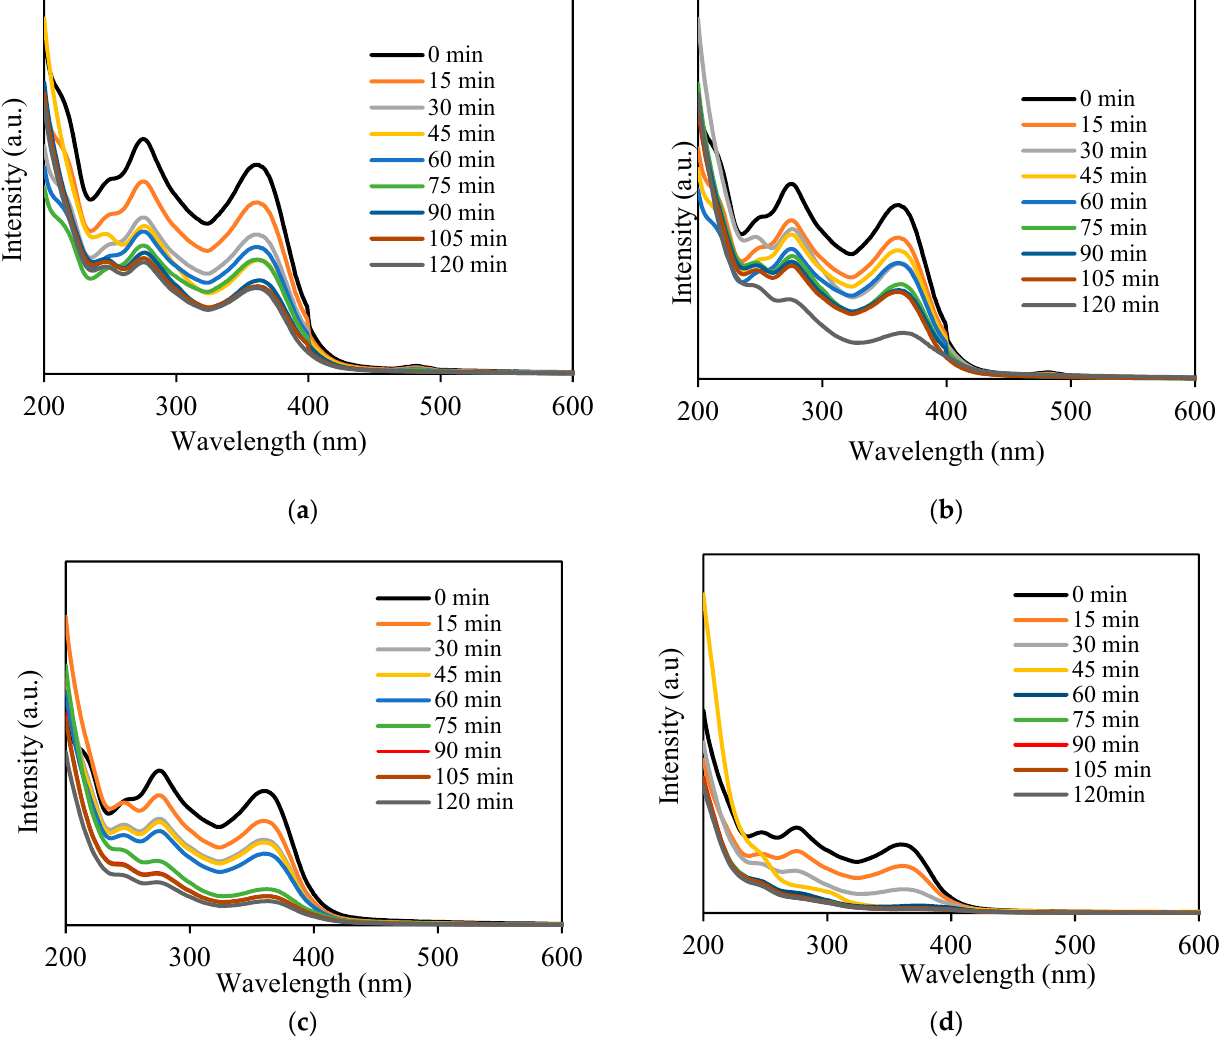
Figure 5. Photocatalytic degradation of tetracycline under visible light irradiation using ( a ) Cu31S16 (120 °C), ( b ) Cu31S16 (150 °C), ( c ) Cu7S 4 (220 °C), and ( d ) Cu7S4 (250 °C) .